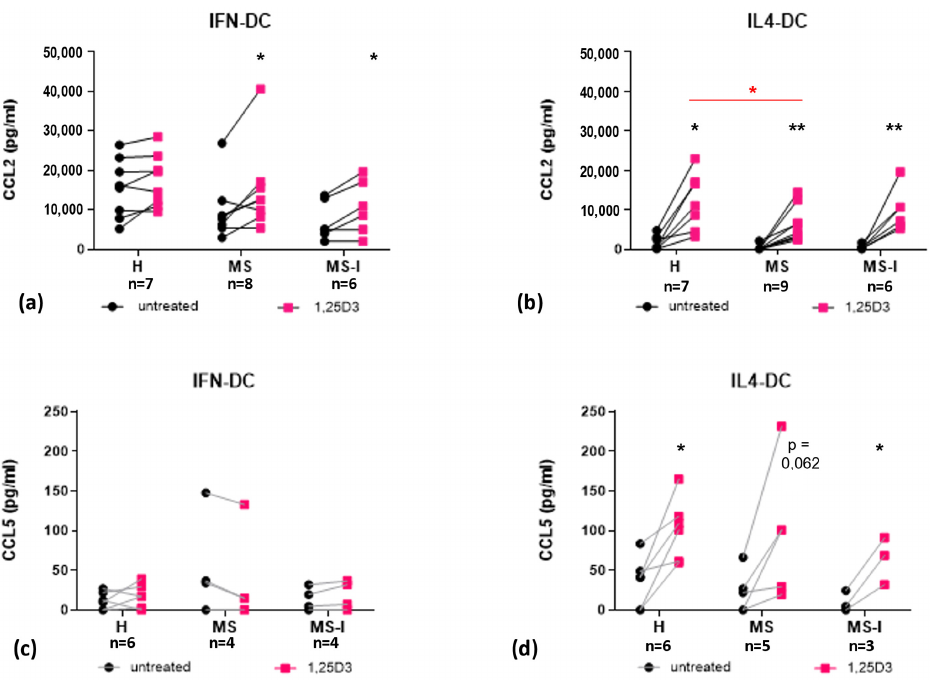
Table 2. Adjusted p values of the indicated comparisons of soluble mediators secreted in IL4- culture supernatants (Tukey’s post- test). Figure 5. Expression and modulation by 1,25(OH) 2 D3 of CCR2 and CCR5 ligands. CCL2 ( a , b ) and CCL5 ( c , d ) concentrations measured in supernatants of IFN-DC ( a , c ) and IL4-DC ( b , d ) from H, MS, and MS-I donors are shown as individual values. Number of subjects (n) analyzed are indicated. MS vs. H Black dots represent untreated cells, pink squares represent 1,25(OH) 2 D3 treated cells. 1,25(OH) 2 D3 untreated